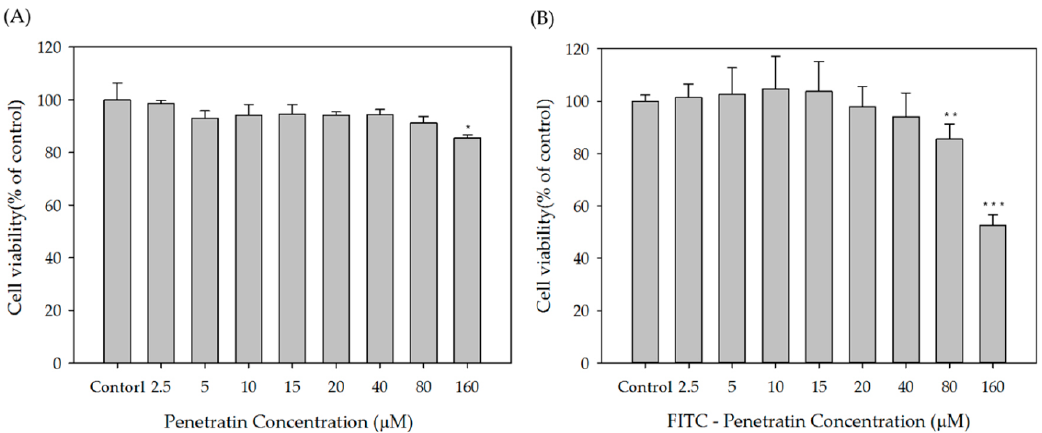
Figure 1. Cell viability of TR146 cells following 24 h of incubation with various concentrations of Penetratin ( A ) and FITC-Penetratin ( B ). Error bars represent SD ( n = 5). * p < 0.05 versus control, ** p < 0.01 versus control and *** p < 0.001 versus control.